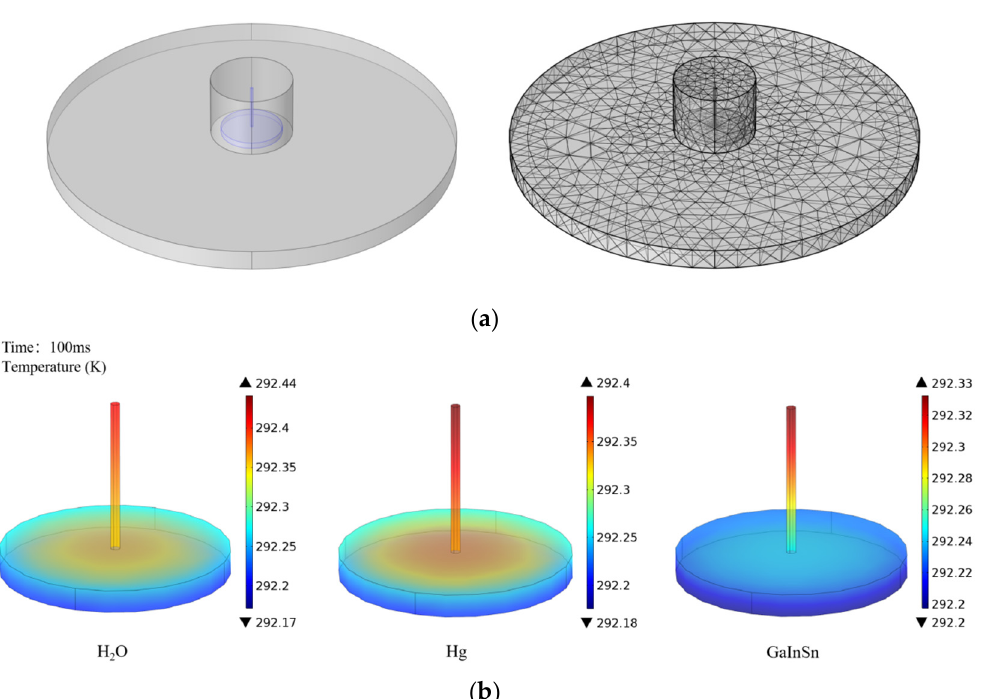
Figure 5. ( a ) Finite element model of diaphragm and filling liquid. ( b ) The heat transfer of the internal liquid at 100 ms when the diaphragm is used as the temperature boundary and the external temperature is 1 K lower than the internal room temperature.